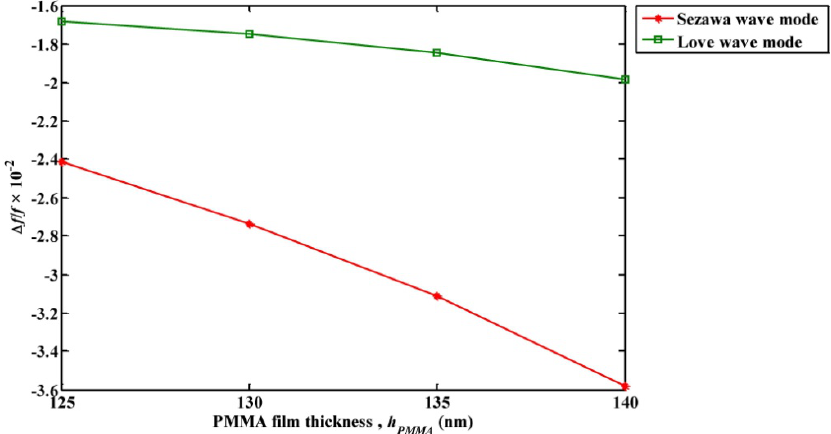
Figure 6. Plot of ratio of Δ f / f versus thickness of PMMA film ( h that Δ f / f obtained for the wave modes are compared at their maximum sensitivity configuration. Accordingly the plots shown are obtained for Δ f at h = 0.21 ZnO